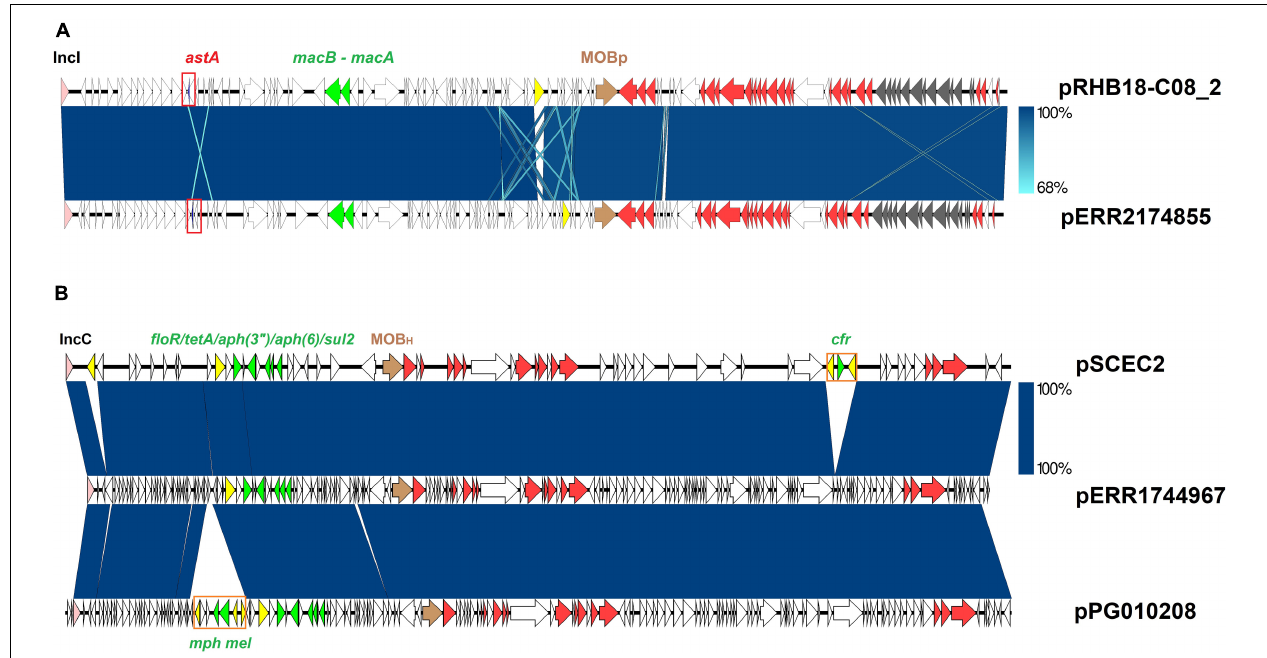
FIGURE 4 | Salmonella plasmids previously identified in other Enterobacteria. Core plasmid sequences are colored pink (Inc replicon), brown (relaxase), and red (tra genes). Transposases and AMR determinants are represented with yellow and green arrows respectively. Blue areas between ORFs denote nucleotide sequence identity. (A) Sequence comparison of the S. enterica plasmid pERR2174855-2 with the Escherichia fergusonii plasmid pRHB18-C08_2 (CP055956.1). E. coli enterotoxin sequence is highlighted with a red square. Gray arrows represent genes coding for the formation of a pilus. (B) Sequence comparison of the S. enterica plasmid pERR1744967-1 with the E. coli plasmids pSCEC2 (KF152885) and pPG010208